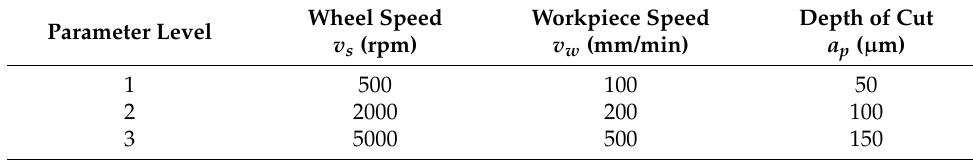
Table 1. Grinding